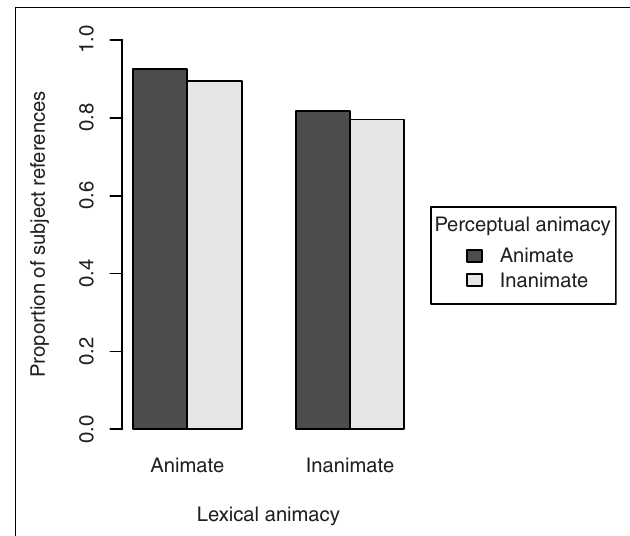
FIGURE 2 | Proportion of subject references to the target figure in the description of the transitive action in Experiment 1, by its lexical and perceptual